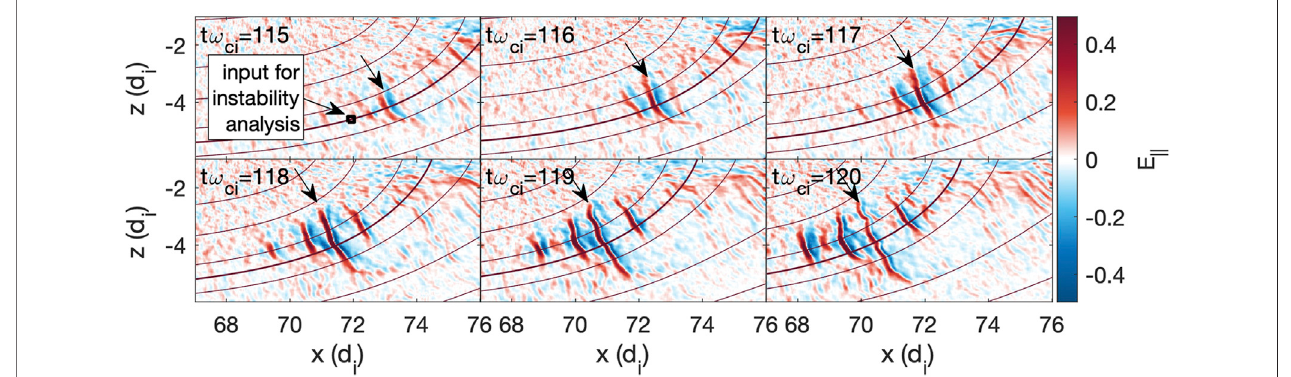
FIGURE 7 | Electrostatic solitary waves inside the southern exhaust. The arrow recurring in every panel identi fi es one given